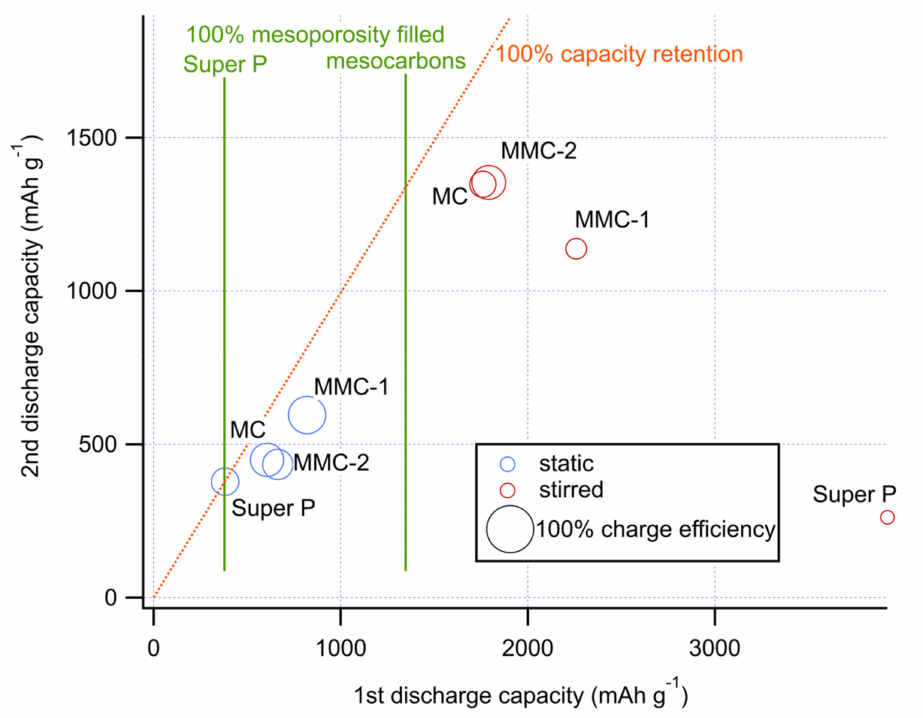
Figure 8. Diagram representing the capacity for the 2nd vs. 1st full discharges in the static (blue) and stirred (red) electrolyte cells. Circle diameter is proportional to charge / discharge coulombic e ffi ciency. The dotted line represents total capacity retention between the first two discharges, green vertical lines represent capacities calculated assuming complete mesoporosity filling by Li 2 O 2 for Super P and the mesocarbons prepared in this